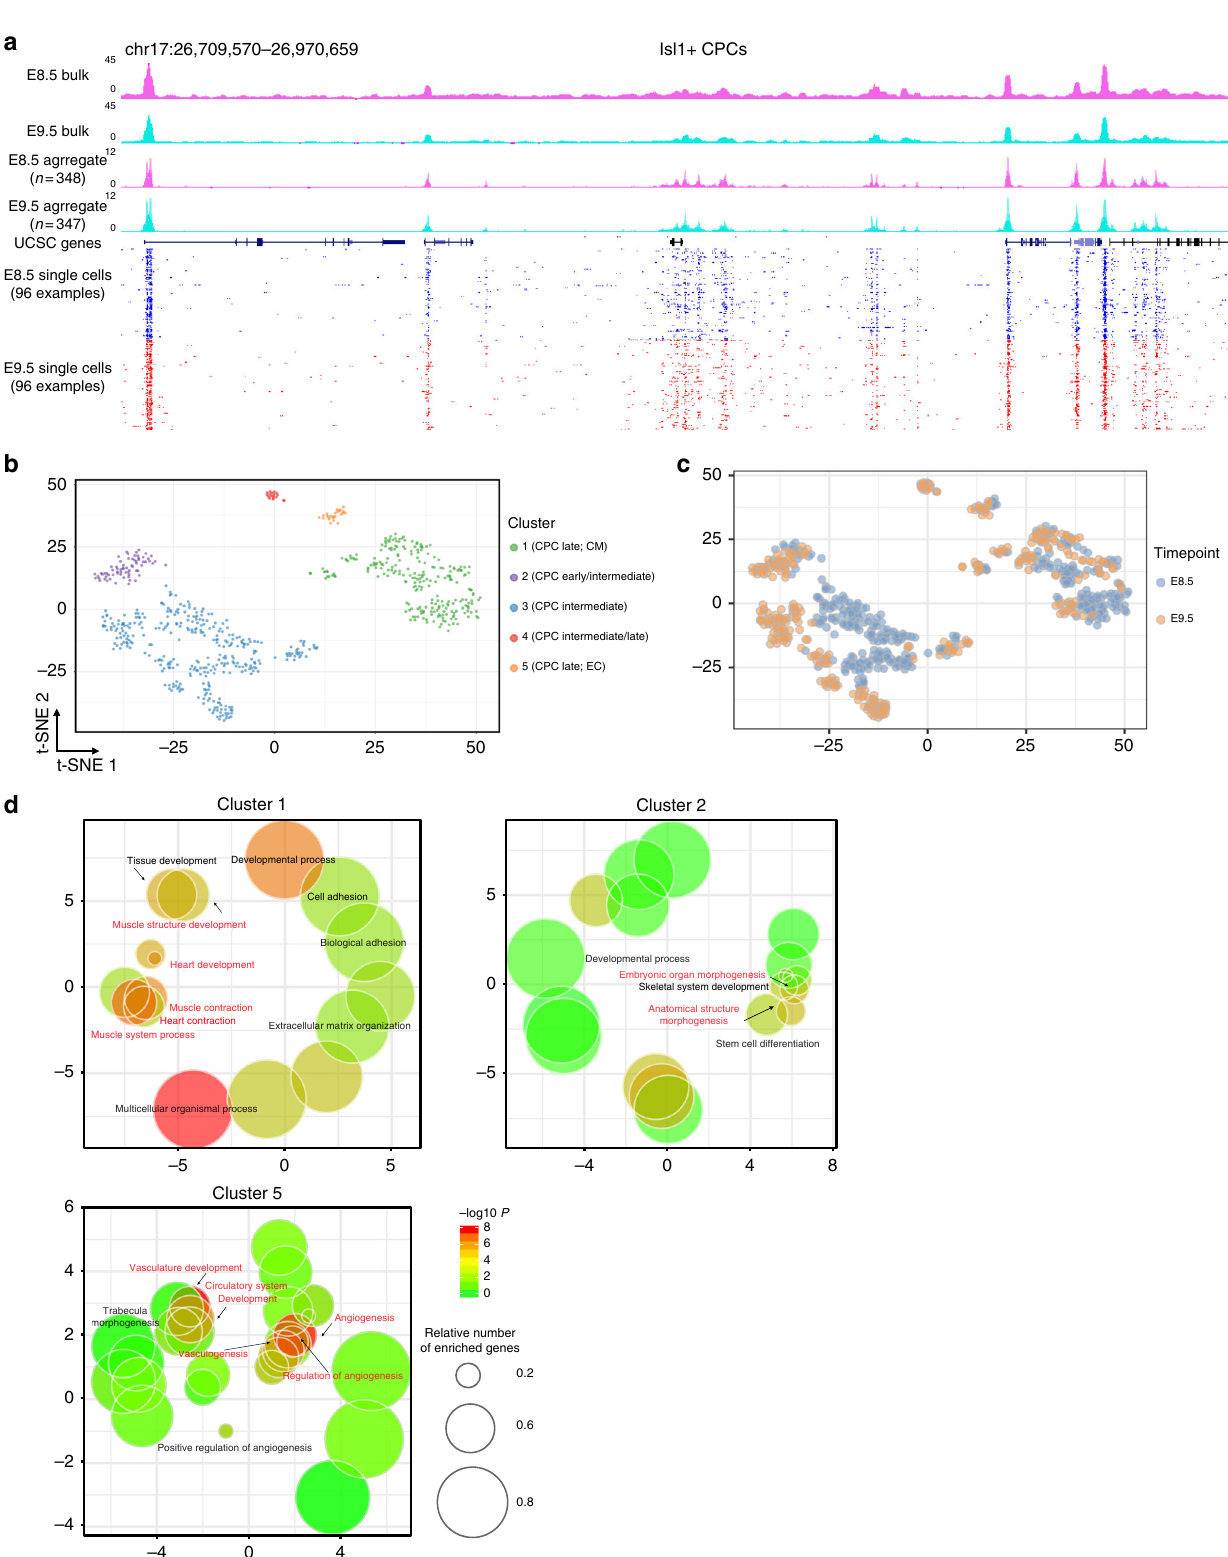
Fig. 7 Single cell chromatin accessibility pro fi les of Isl1 + CPCs. a Representative genomic region showing ATAC-seq tracks of single, aggregate and bulk cells. b, c t-SNE visualization of individual Nkx2-5 + and Isl1 + CPCs to identify subpopulations based on chromatin accessibility. Colors denote corresponding clusters ( b ), and ( c ) development stages. d Gene ontology (GO) enrichment analyses of scATAC-seq clusters 1, 2, 5 of Isl1 + CPCs. Each bubble represents one of the top enriched GO terms. The relevant GO terms ( p < 0.05, calculated from the hypergeometric distribution) are